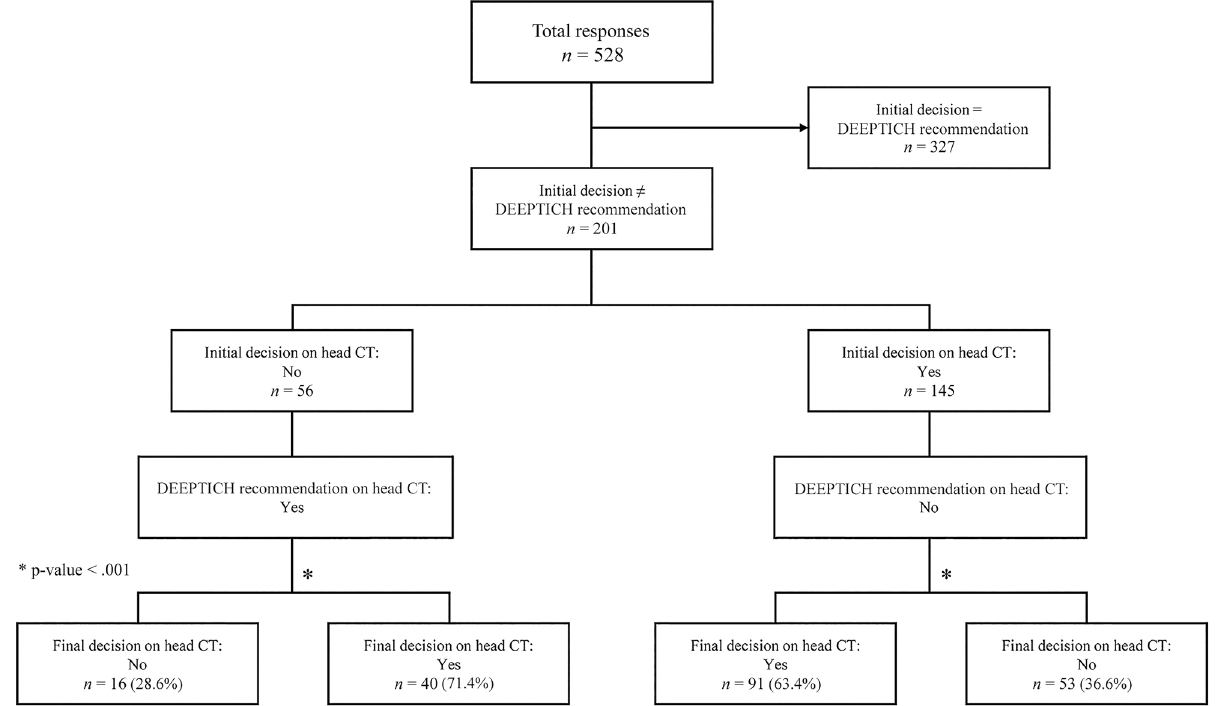
Figure 2. Ordering a head CT binary decision results on the simulation